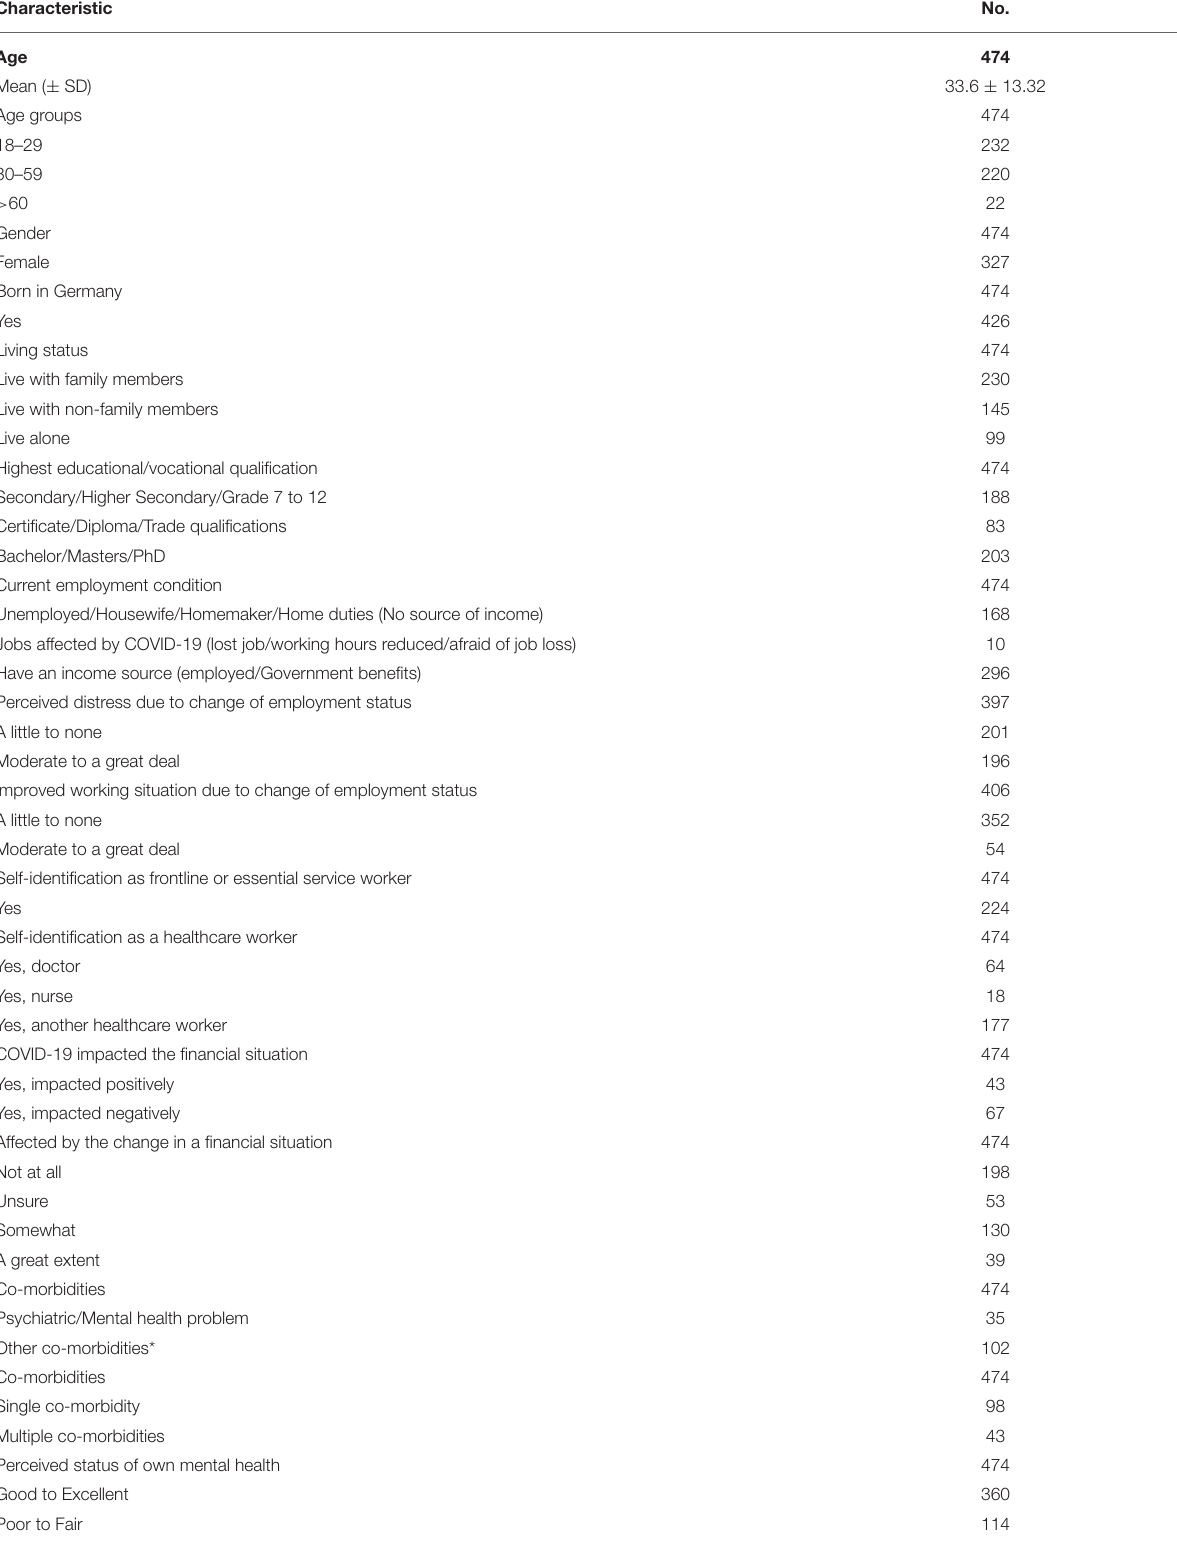
TABLE 1 | Baseline demographic characteristics of the participants ( N =